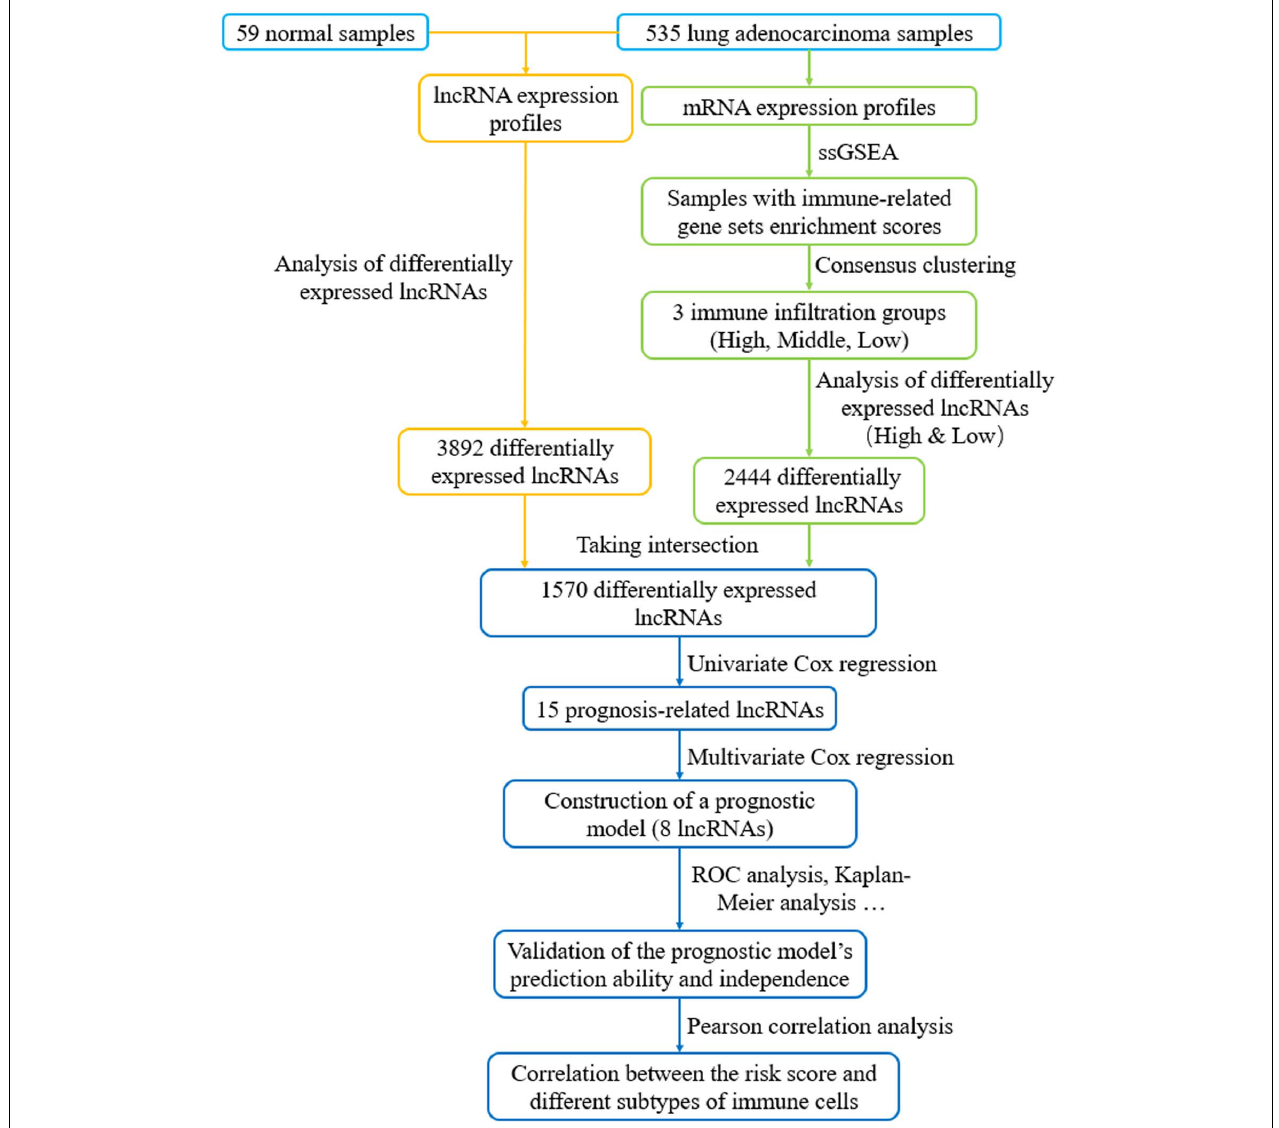
FIGURE 1 | Flow chart of constructing a prognostic signature based on eight immune-related lncRNAs. LncRNAs related to immune infiltration and cancer occurrence were screened to build an eight-lncRNA prognostic signature. The predictive accuracy and independence of the signature in prognosis of LUAD were testified, and correlation between the signature-based risk score and abundance of several immune infiltrates was